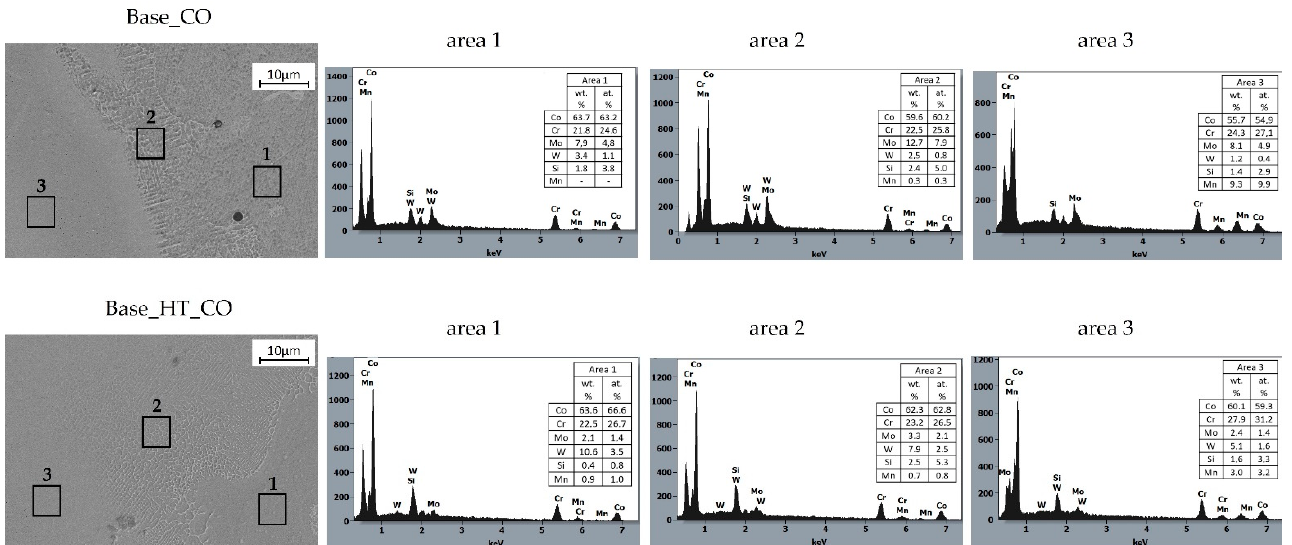
Figure 5. Microstructures of welded material configurations (LOM) after corrosion resistance tests, where base is non ‐ welded CoCrMoW alloy, 0 is laser welding without filler metal, ST is welded with stainless steel wire, CO is welded with cobalt alloy wire, and HT refers to samples subjected to heat treatment after welding.